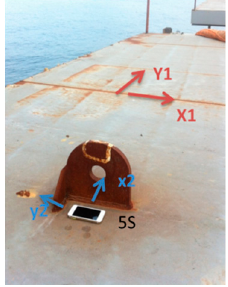
Figure 15. Arrangement of the collector (i.e., the iPhone 5S).